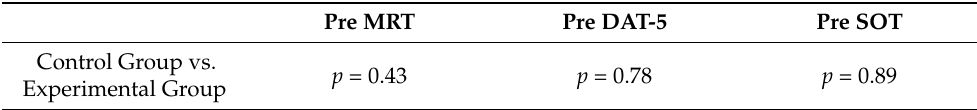
Table 4. p -Values prior training in each of the components of Spatial Skills. Pre MRT Pre DAT-5 Pre SOT Control Group vs. Experimental